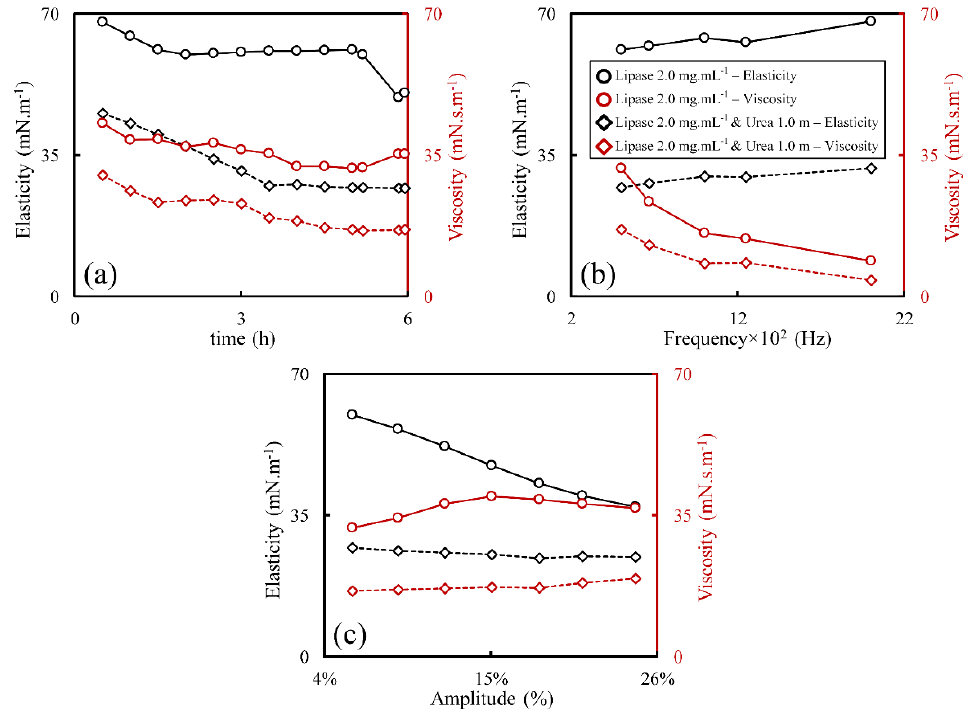
Figure 7. Effect of aging on the viscoelastic properties of the adsorbed layers from 2 mg · mL − 1 lipase solution in the absence and presence of 1 molal urea: ( a ) viscoelasticity evolution over time studied by imposing sinusoidal perturbations of 0.05 Hz frequency and 5% amplitude ( ∆ A / A 0 ); ( b ) viscoelasticity versus frequency studied after 18,000 s from the start of the test; ( c ) viscoelasticity versus amplitude studied after 18,700 s from the beginning of the test; the solid and dashed lines are drawn as guides for the eye.